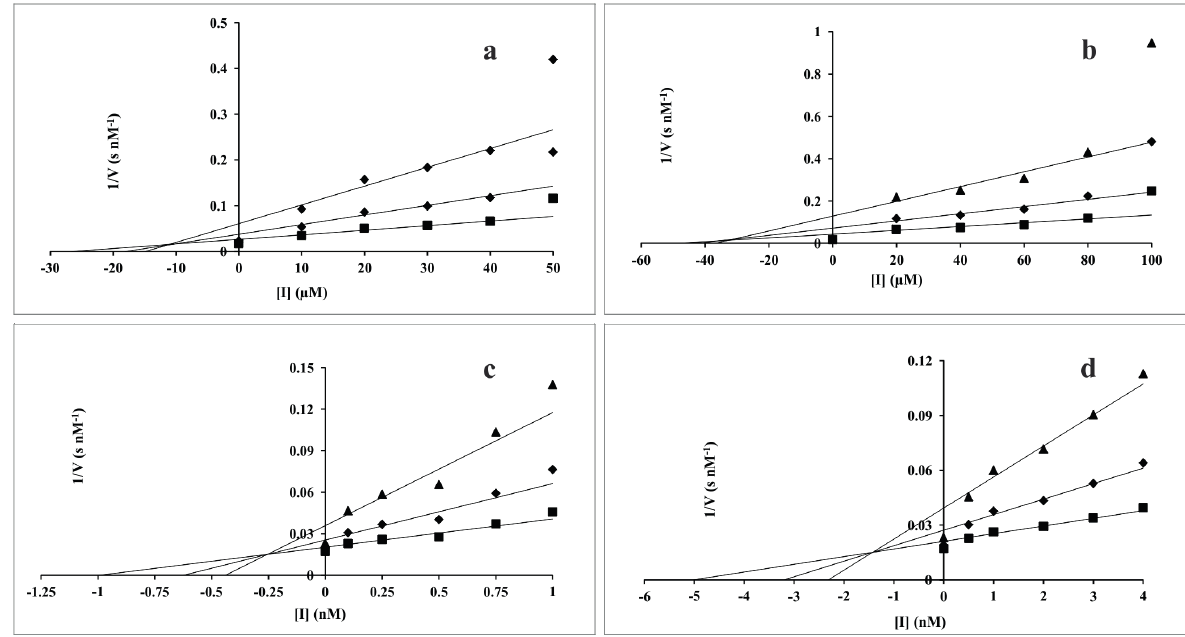
Figure 5. Dixon’s plot of the inhibition of intestinal trypsin- like of Anticarsia gemmatalis (Lepidoptera: Noctuidae) by the inhibitors ( a ) benzamidine, ( b ) berenil, ( c ) SKTI and ( d ) SBBI in the presence of L-BApNA substrate (S). The lines were calculated by linear regression using the parameters of Table II. The points are experimental. S1 ( ), S2 ( ), S3 ( ■ ).